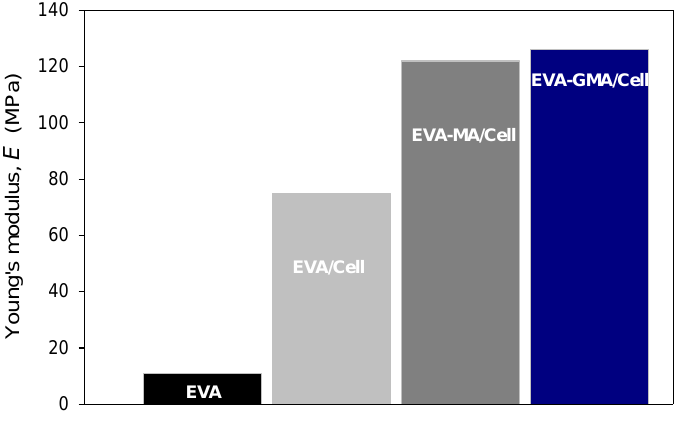
Figure 17 . Effect of polymer functional groups on the Young modulus of EVA/Cell composites.